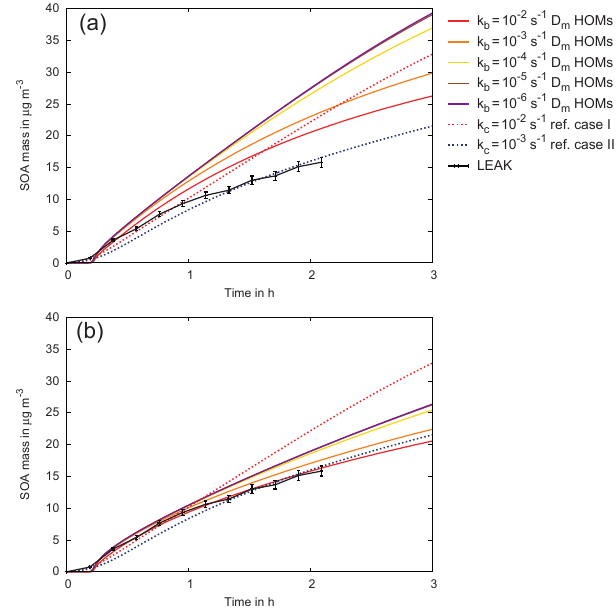
Figure 8. Simulated SOA mass considering an effective particle- phase bulk diffusion coefficient as well as HOMs, a constant pseudo-first-order rate constant of particle reactions k c = 10 − 2 s − 1 and under additional variation of the chemical backward reaction rate constant of particle reactions k b in comparison with aerosol chamber measurements from LEAK. (a) Organic material is con- sidered with a diffusion coefficient of D org = 10 − 12 m 2 s − 1 in the weighted diffusivity D m (solid lines); (b) organic material is considered with a diffusion coefficient of D org = 10 − 14 m 2 s − 1 in the weighted diffusivity D m (solid lines). For comparison, in both plots the results for a constant particle-phase bulk diffusion coef- ficient D b = 10 − 12 m 2 s − 1 combined with two different pseudo- first-order rate constants of particle reactions k c = 10 − 2 s − 1 (ref. case I) and k c = 10 − 3 s − 1 (ref. case II) are included (dashed lines).